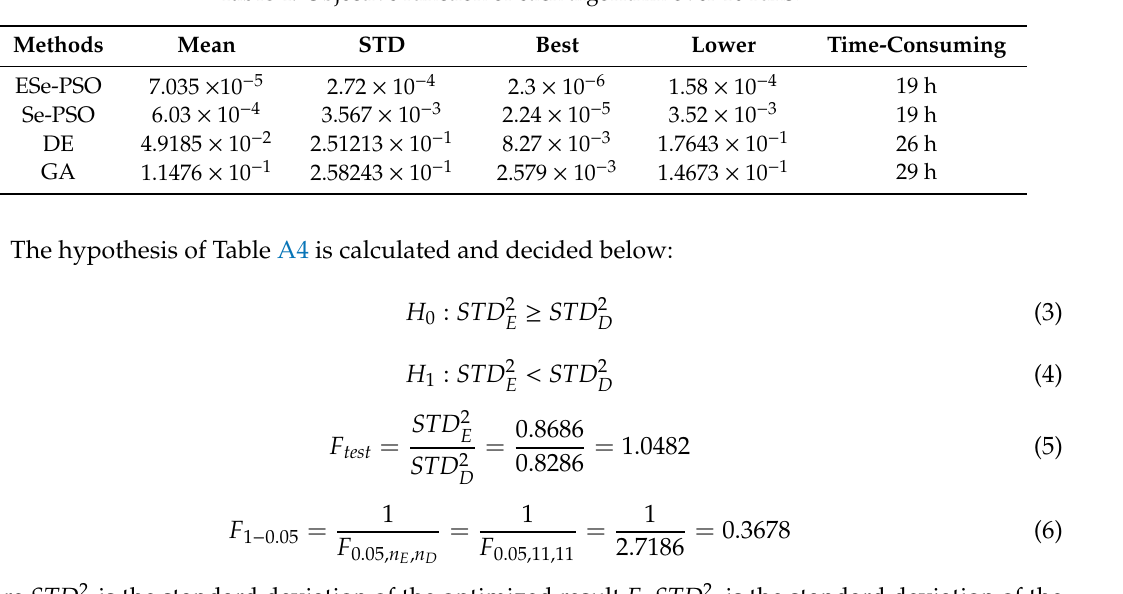
Table 4. Objective function of each algorithm over 10